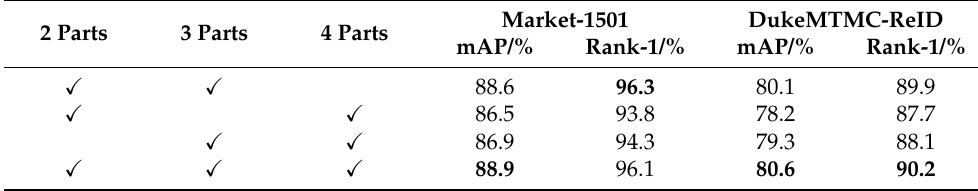
Table 6. Comparative experiment of the local feature